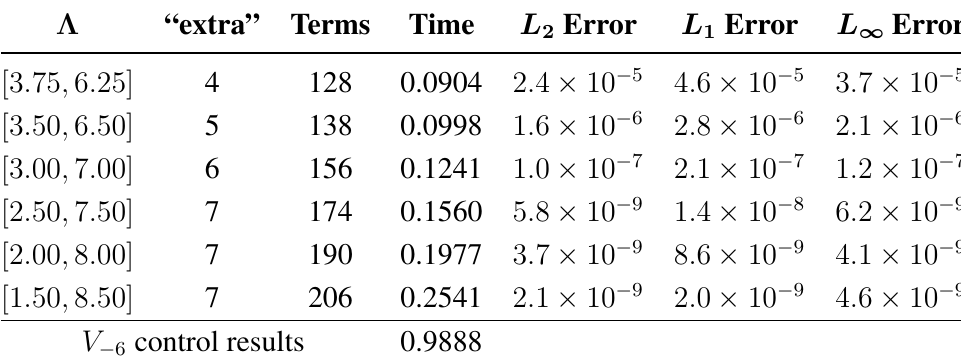
Table 1. Burgers’ equation error for multi-scale systems. By “Time” we mean the average computing time (in seconds) per time step. Note that the errors are only calculated in the region [1 . 5 , 8 . 5] .